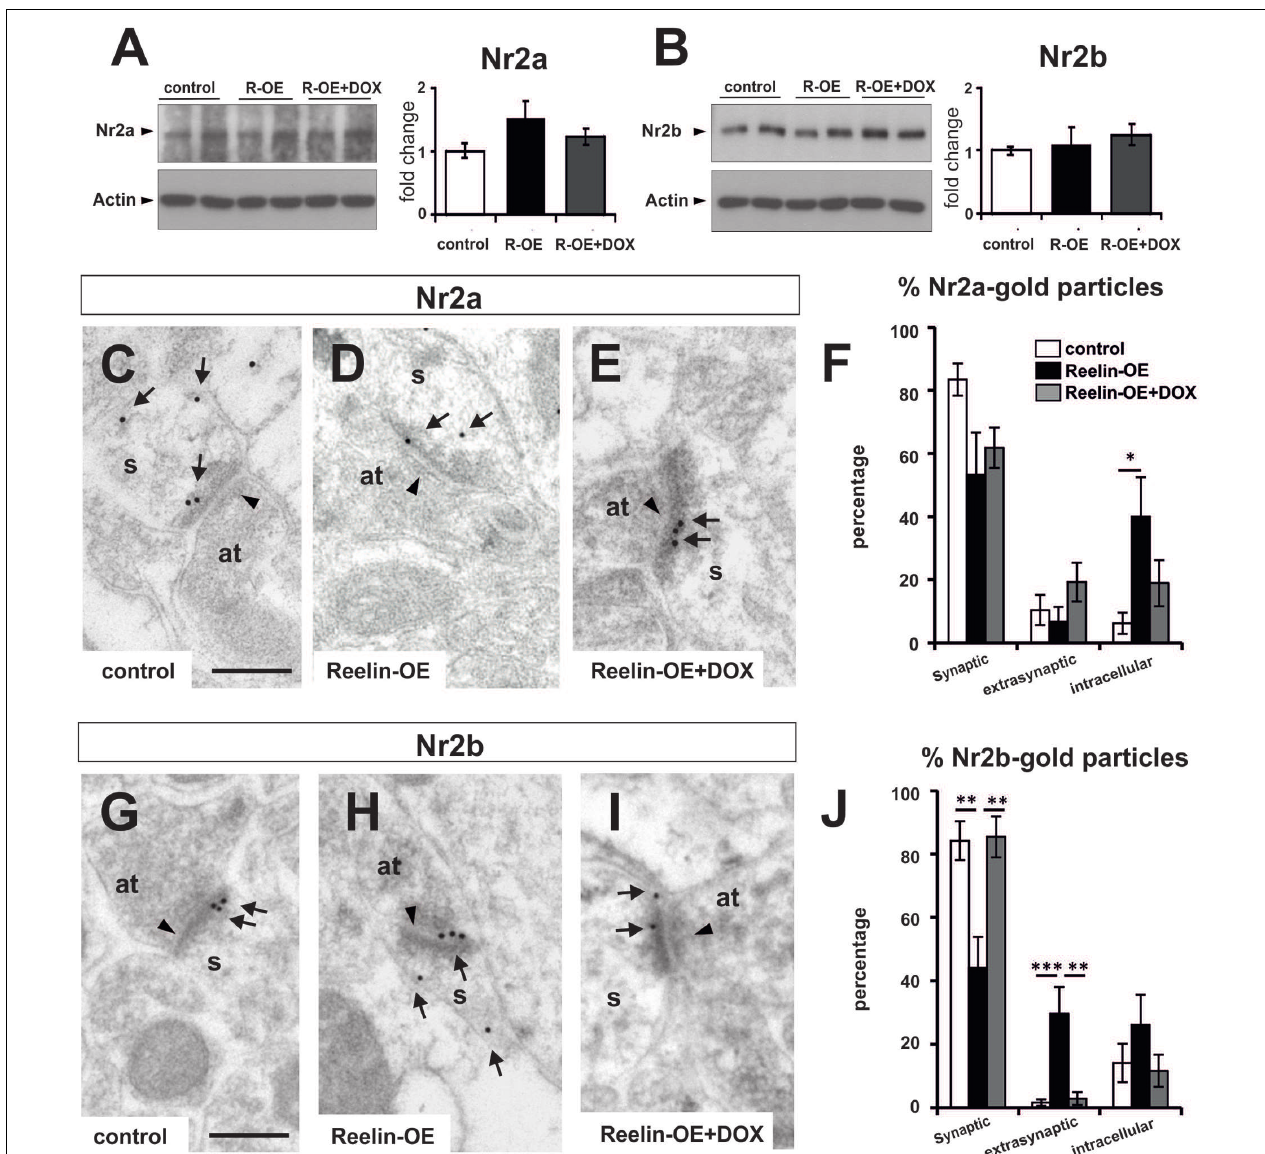
FIGURE 4 | Expression of NMDA receptor subunits NR2a and NR2b in Reelin-OE mice. (A) Left, immunoblot analysis of NR2a in control, Reelin-OE, and DOX-treated Reelin-OE mice. Right, histogram showing densitometric analysis ( n = 4 animals per group) by fold change in the three groups of mice (mean ± SEM; ANOVA test). (B) Left, immunoblot analysis of NR2b in control, Reelin-OE, and DOX-treated Reelin-OE mice. Right, histogram showing densitometric analysis ( n = 3 animals per group) by fold change in the three groups of mice (mean ± SEM; ANOVA test). (C–E) Examples of immunogold labeling against NR2a in dendritic spines (s) receiving a synaptic contact from an axon terminal (at) in the SR of control (C) , Reelin-OE (D) , and DOX-treated Reelin-OE (E) mice. (F) Histogram illustrating the proportion of NR2a-gold particles in the synaptic contact, the extrasynaptic membrane and the intracellular domain of dendritic spines in the SR of Reelin-OE and DOX-treated Reelin-OE mice and their control littermates (mean ± SEM; ∗ p < 0.05; ANOVA test). (G–I) Examples of immunogold labeling against NR2b in dendritic spines (s) receiving a synaptic contact from an axon terminal (at) in the SR of control (G) , Reelin-OE (H) , and DOX-treated Reelin-OE (I) mice. (J) Histogram illustrating the proportion of NR2b-gold particles in the synaptic contact, the extrasynaptic membrane and the intracellular domain of dendritic spines in the SR of Reelin-OE and DOX-treated Reelin-OE mice and their control littermates (mean ± SEM; ∗∗ p < 0.01, ∗∗∗ p < 0.001; ANOVA test). In (C–E,G–I) , note synaptic contacts pointed by arrowheads and immunolabeling dots labeled by arrows. Scale bars, 250